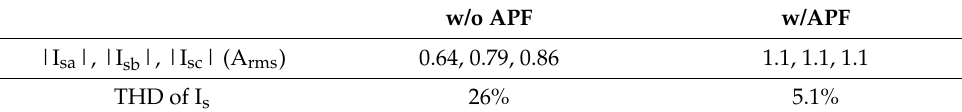
Figure 11. ( a ) v ab-pcc , i sa and i sb without the filter. ( b ) v ab-pcc , i sa , i sb and i fb with the filter. (10 ms/div). Case 2: Unbalanced magnitudes and phases of the grid voltages ( A ) NL Under NL conditions, the THD of source currents decreased from 26 to 5.1%, as seen in Table 9. The magnitude of the source currents was also balanced. Therefore, the source currents were sinusoidal with approximately the same amplitude as presented in Figure 12b. Table 9. Magnitudes and THD of the source currents.